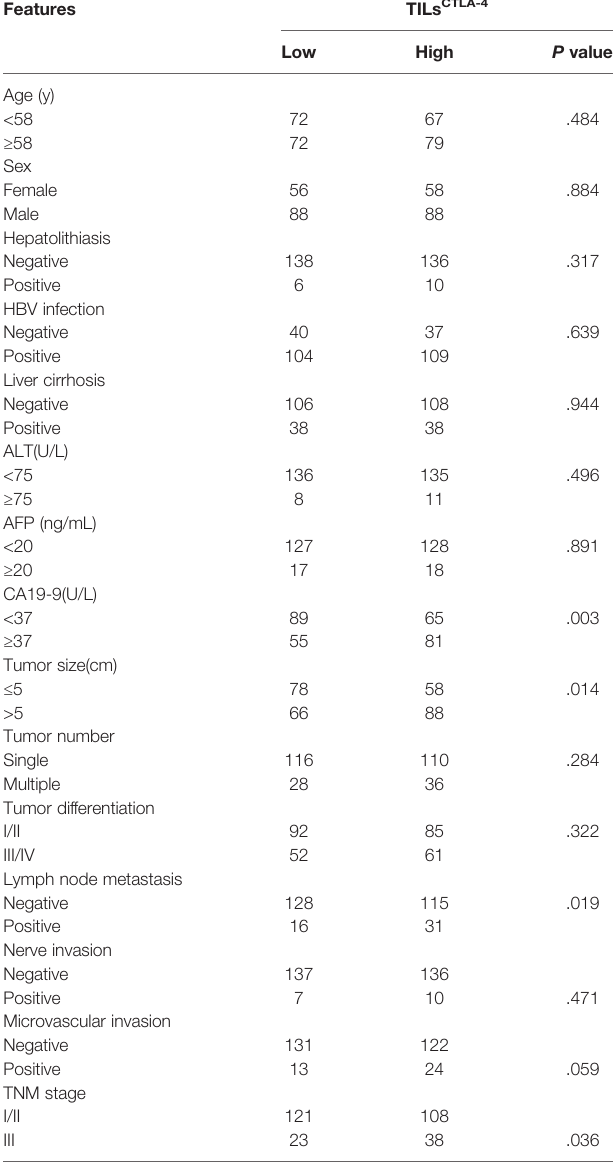
TABLE 1 | Correlation between CTLA-4 and clinicopathological features in 290 patients with ICC.